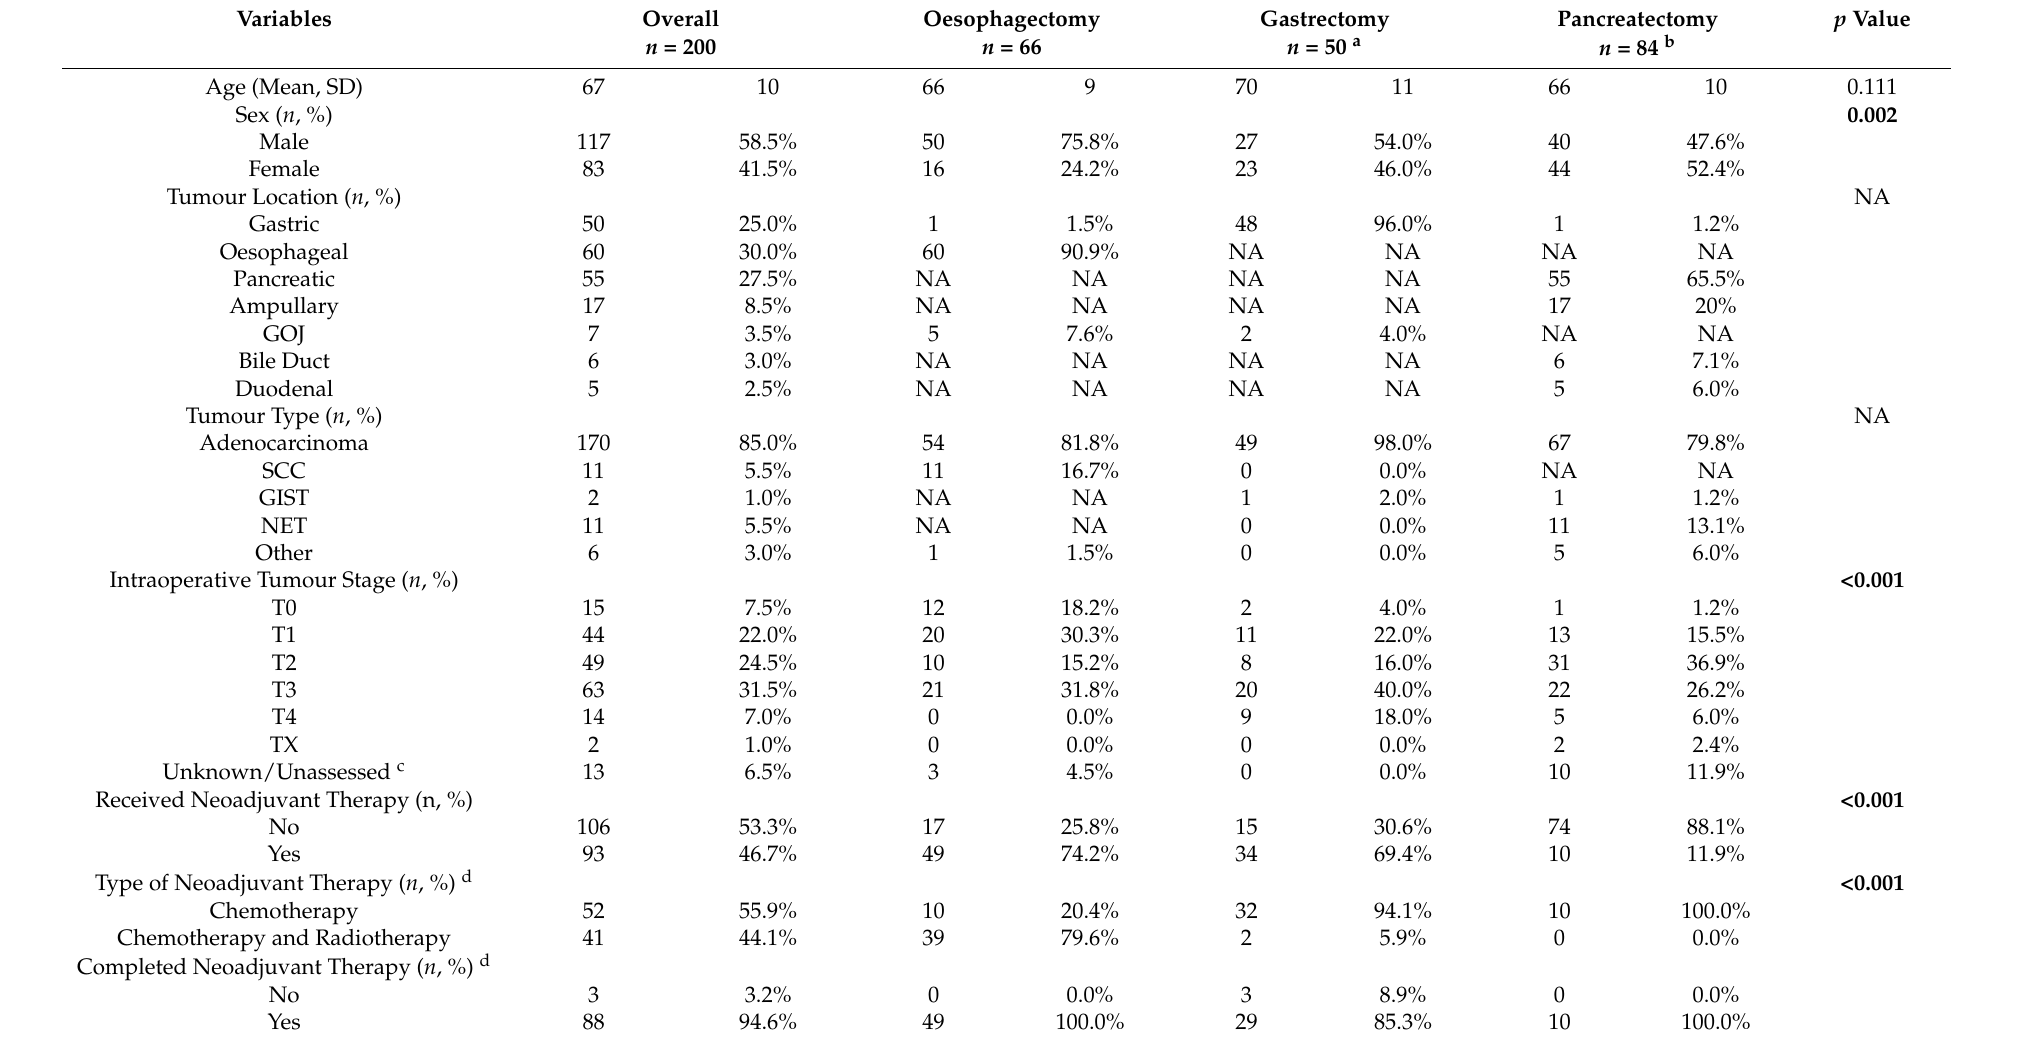
Table 1. Demographic, tumour and surgical characteristics by surgery